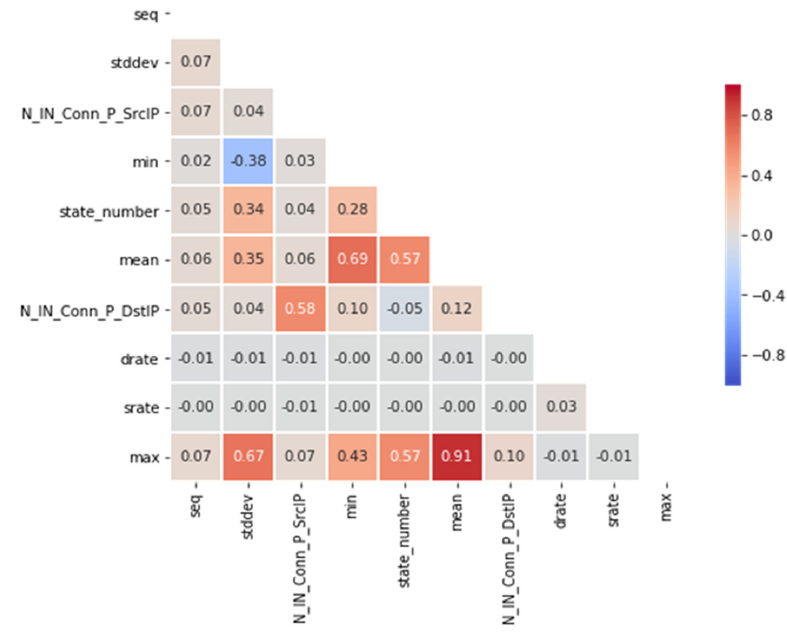
Figure 3. Heatmap in view of the relationship between elements.